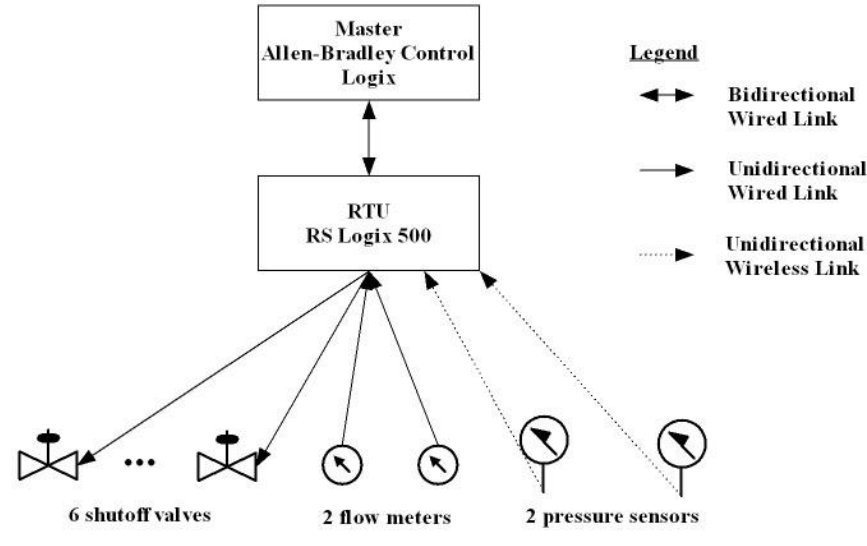
Figure 16. CPSR system architecture.